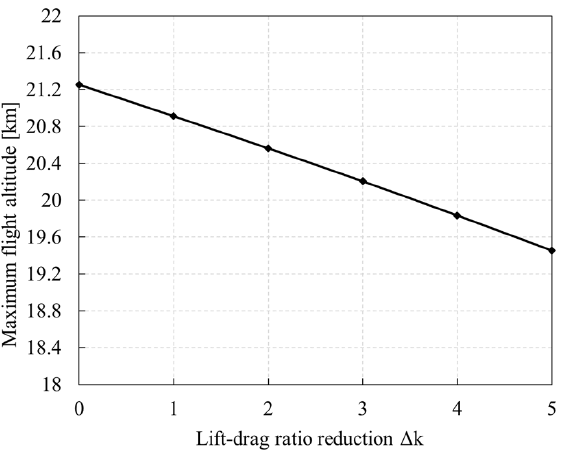
Figure 36. Influence of lift–drag ratio reduction on maximum flight altitude (Mar. 21, 41° N).